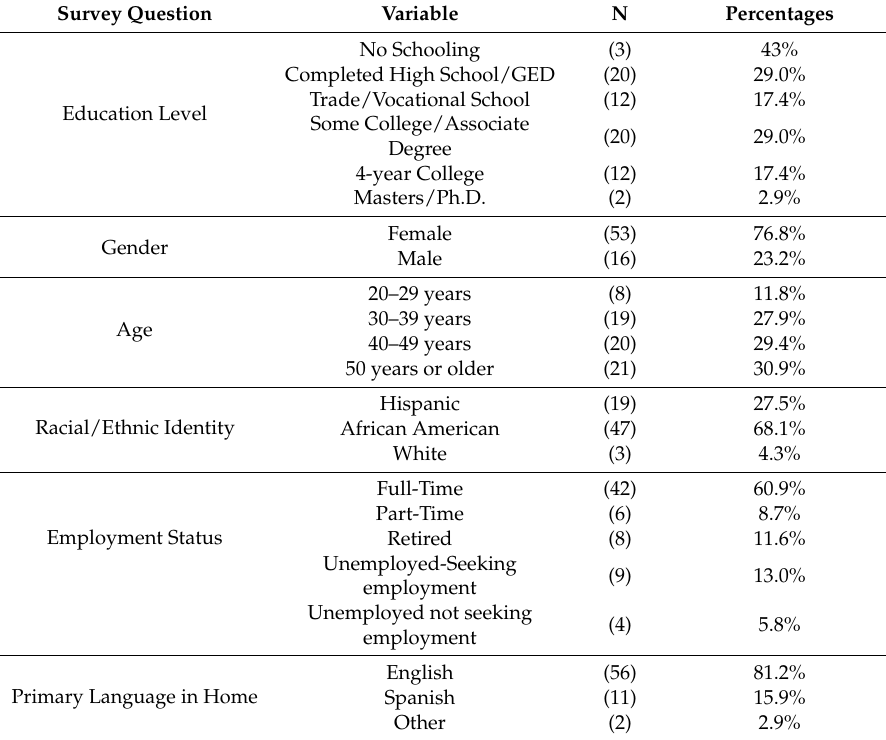
Table 5. Socio Economic Characteristics of Houston Habitat